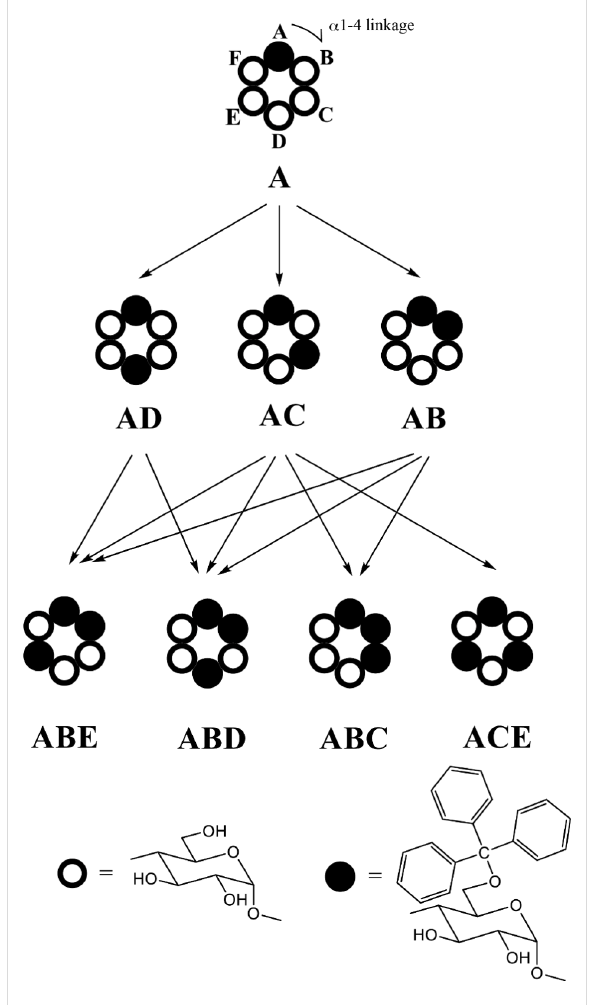
Scheme 1: Tritylates of α -CD examined in the present study and the reaction pathway. Letters A to F represent the glucopyranose units along with α 1-4 linkage direction, numbered when viewed from the secondary hydroxy group side.